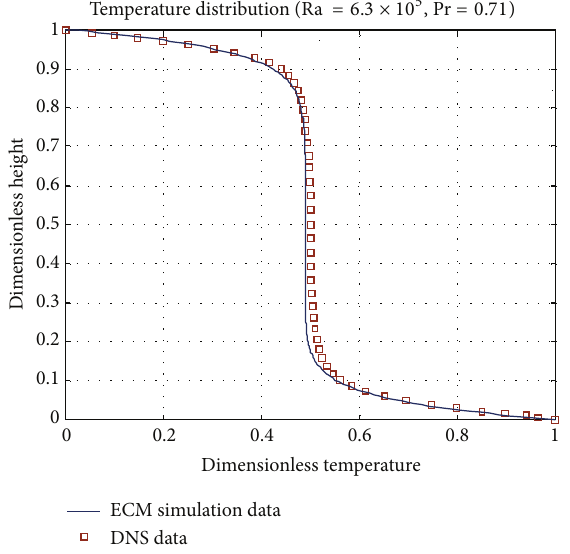
Figure 10: ECM predicted versus DNS [19] temperature profiles.